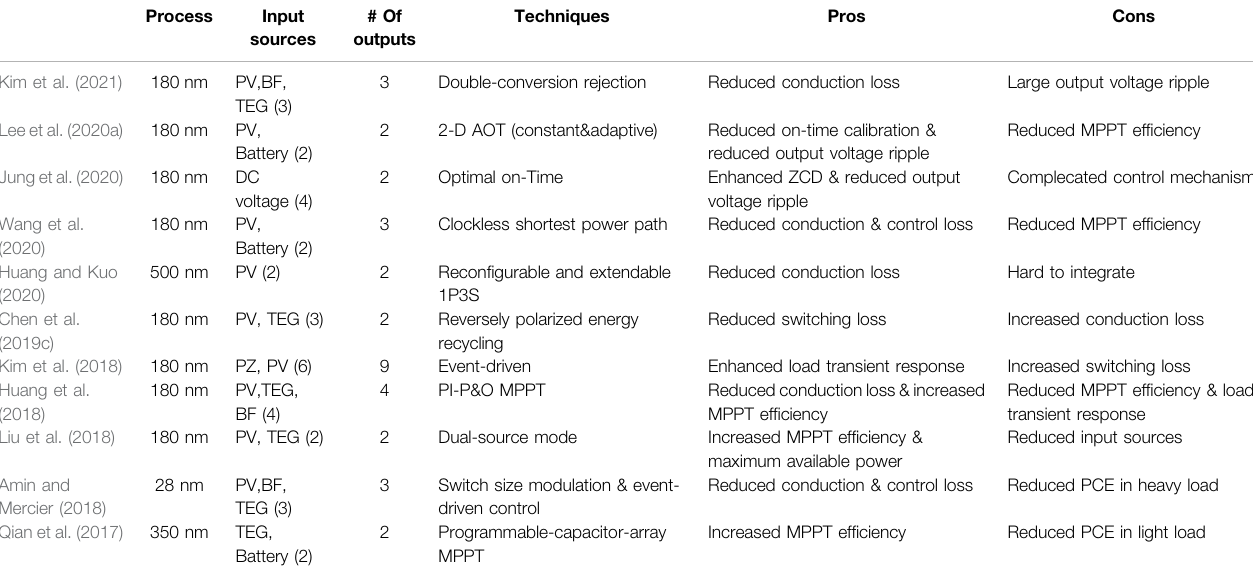
TABLE 1 | Comparison between state-of-the-art MISIMO EH